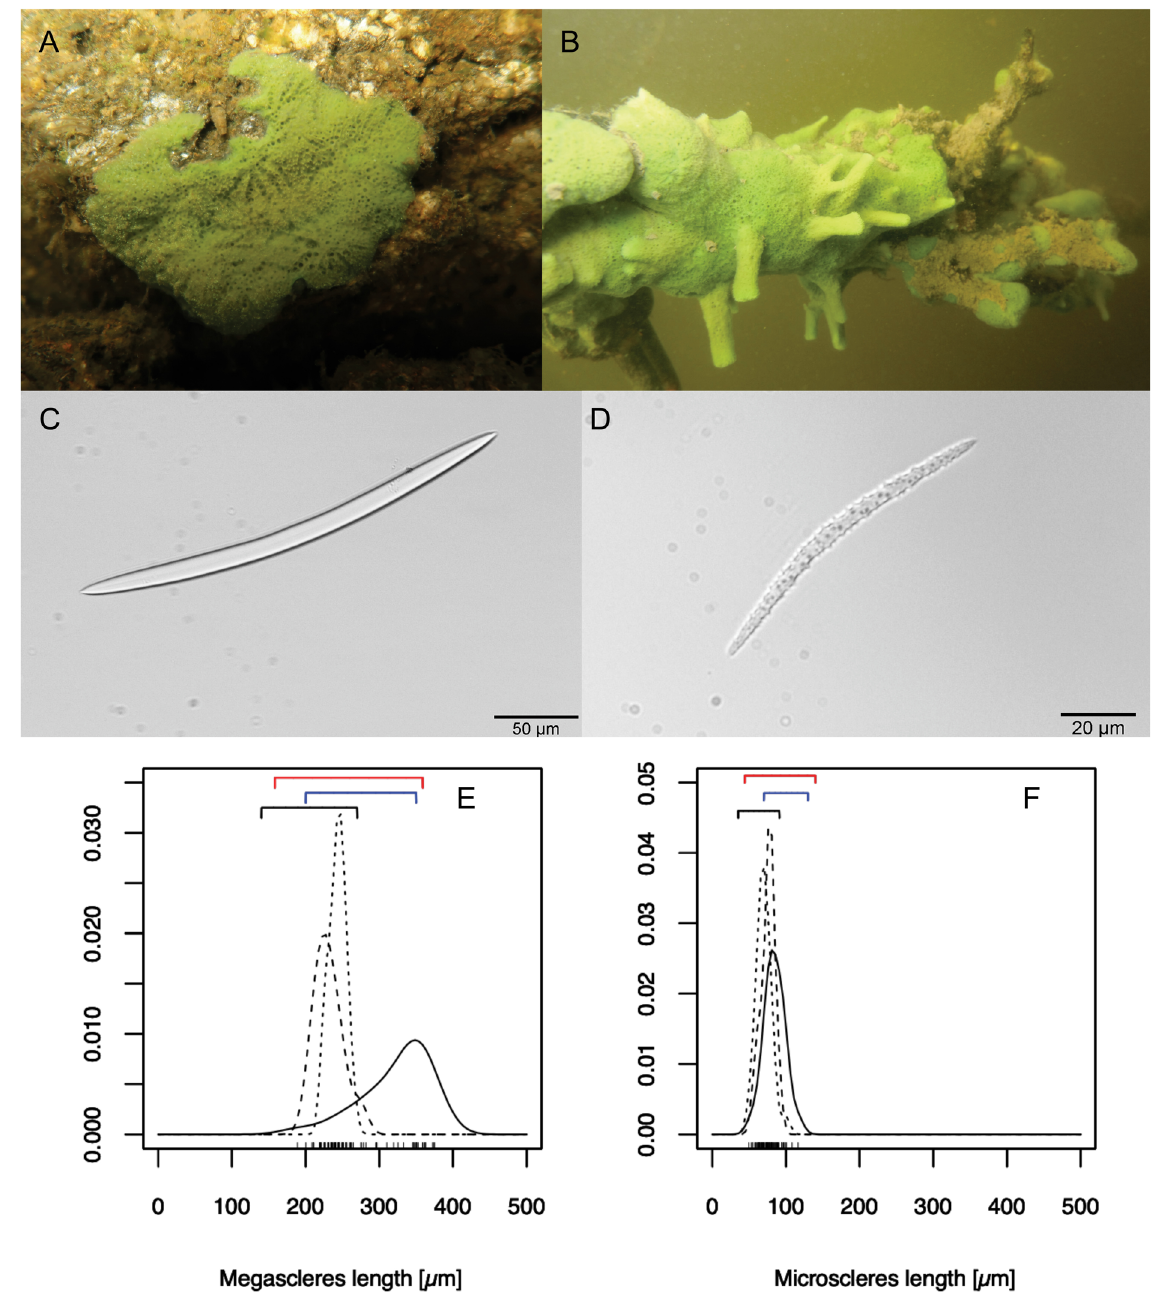
Fig. 2. Spongilla lacustris (Linnaeus, 1759). A–B . Habitus. A . Specimen growing under a pontoon (P059-171011-6). B . Specimen growing on anchor chain, with finger–like projections (P059-170802- 48). C–D . Spiculae. C . Megasclere (P059-171008-4). D . Microsclere (P059-171008-1). E–F . Estimated spicula size distribution within and between specimens, P059-130831-1 (solid line), P059-170802- 8 (dashed) and P059-171008-4 (dotted). Marks on the x-axis represent spiculae measured. Brackets correspond to ranges in literature (red = Tendal 1967b; blue = Penney & Racek 1968; black = Evans & Montagnes 2019). E . Megascleres. F .